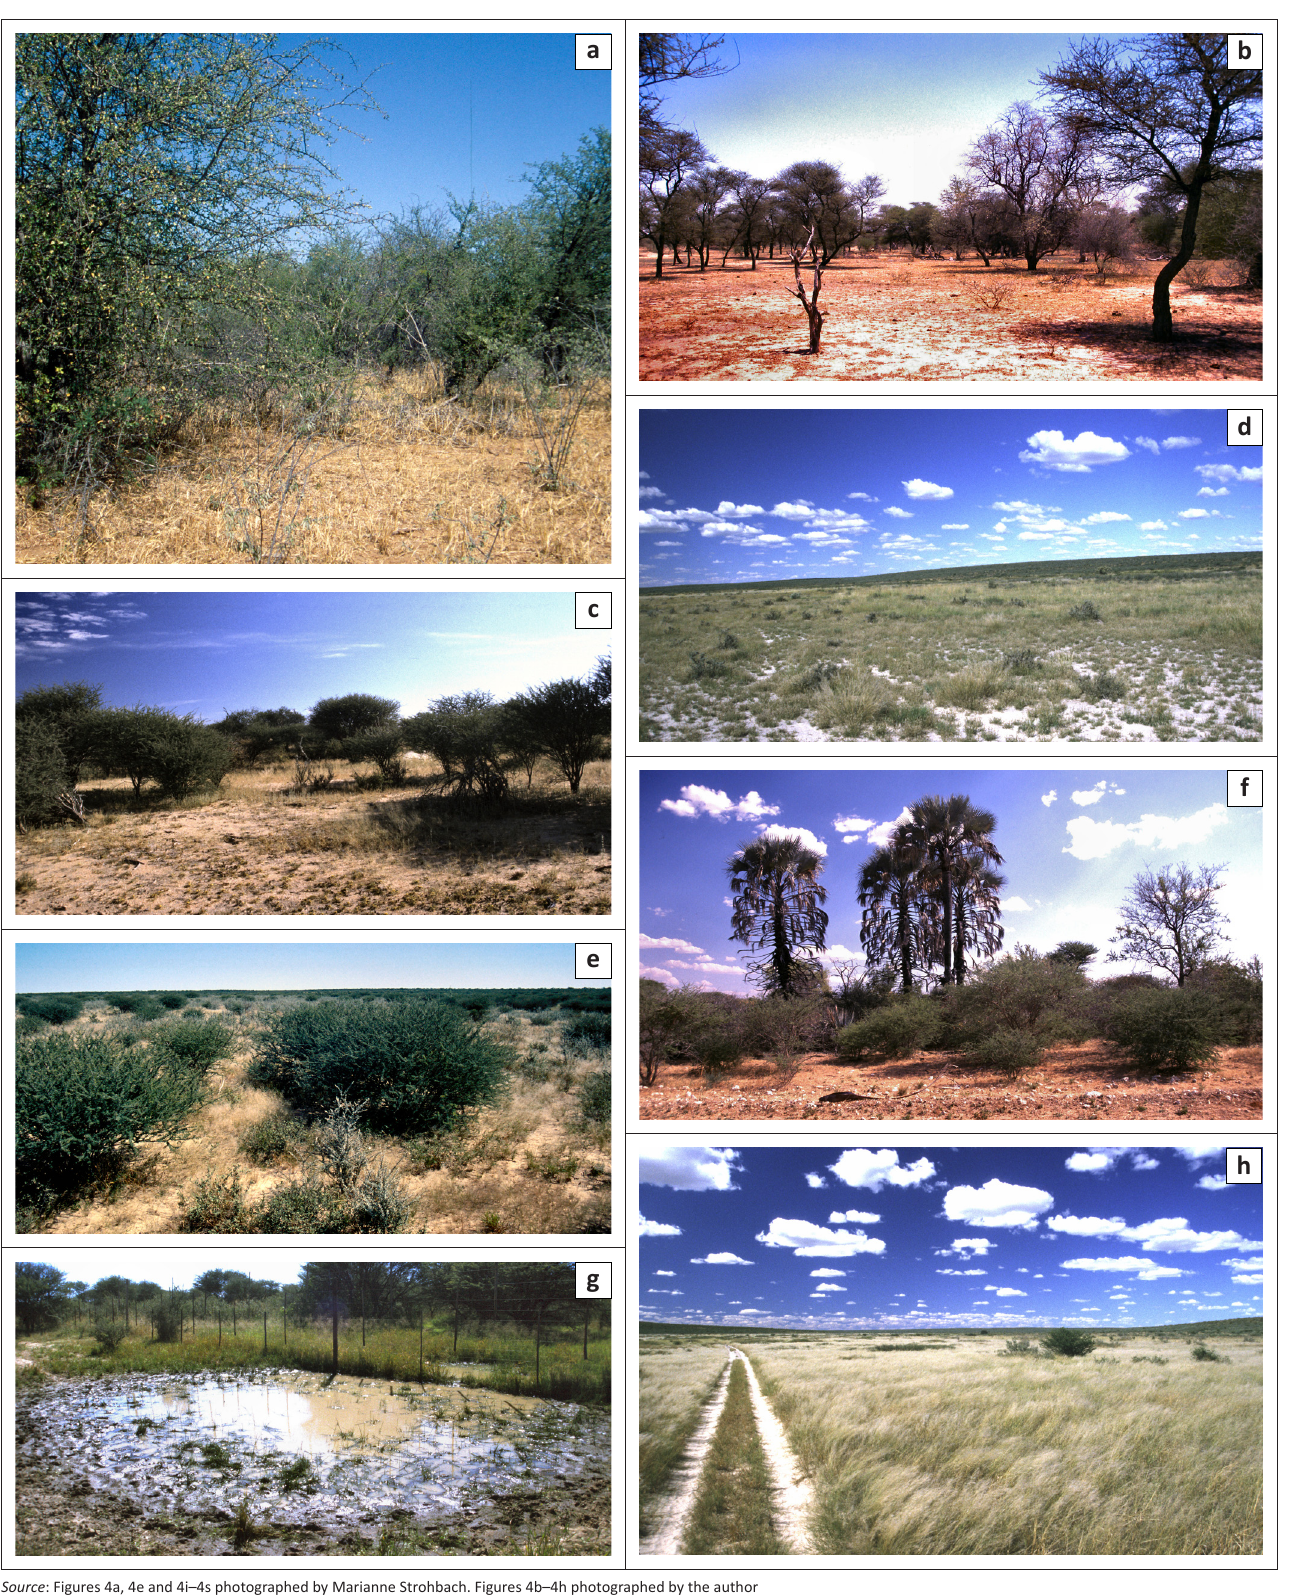
FIGURE 4: Typical examples of various associations and subassociations, (a) Acacio fleckii–Terminalietum prunioidis , (b) Acacio tortilis–Combretetum imberbis , (c) Ptycholobio biflori–Acacietum luederitzii , (d) Eragrostio echinocloideae–Eriocephaloetum luederitziani , (e) Acacio melliferae–Catophractetum alexandri , (f)